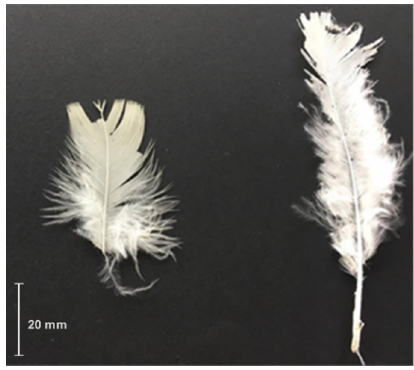
Figure 3. Chicken feathers (CFs) as received from a Chilean poultry company.